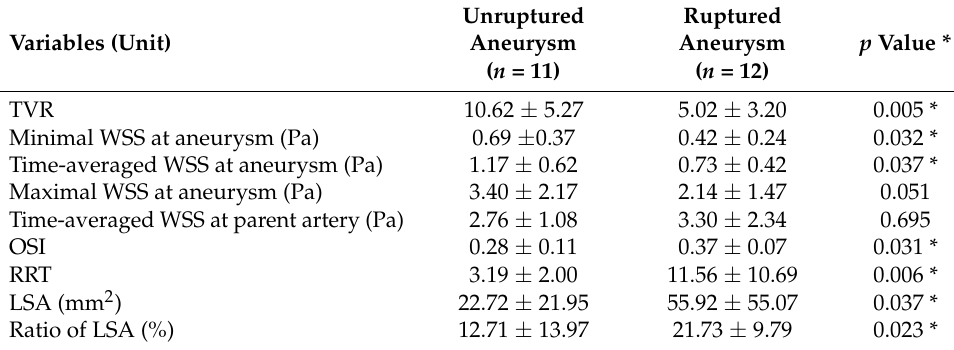
Table 3. Quantification of hemodynamic